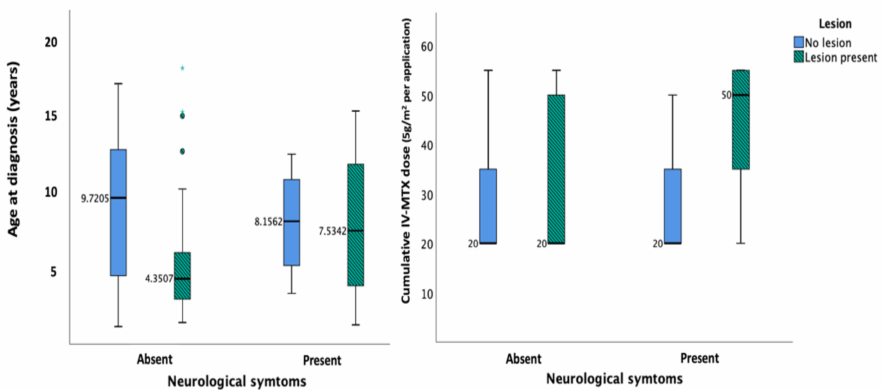
Figure 3. Box plots demonstrating the relationships between lesion presence, age, and cumulative IV- MTX dose. Median values of age at diagnosis (years) and cumulative IV-MTX dose are presented for subgroups of lesioned (green-striped) or non-lesioned (blue) patients, with or without neurological symptoms. Patients exhibiting lesions have lower ages at diagnosis on average (left panel). Both neurological symptoms and lesions are associated with higher cumulative IV-MTX dose (right